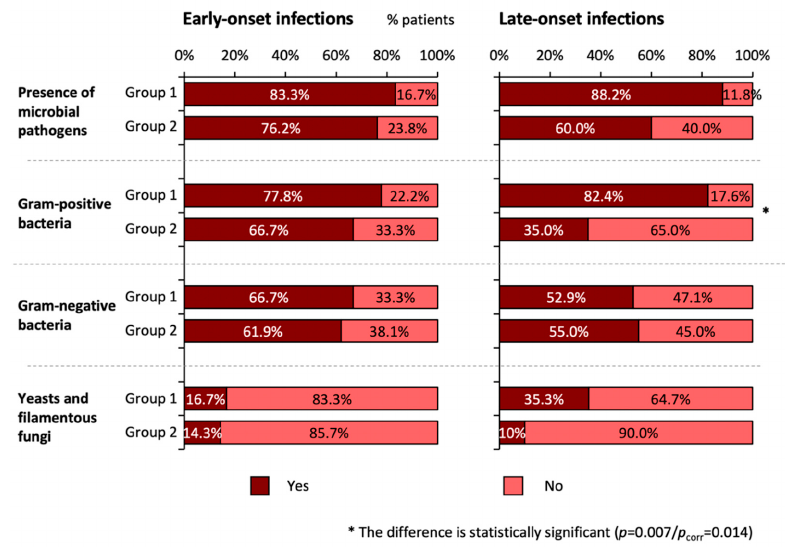
Figure 2. The incidence of early-onset ( n = 39) and late-onset infectious complications ( n = 37; 2 patients died less than 5 days after admission) in patients with toxic epidermal necrolysis (TEN) in the context of the use of antibiotics before TEN development. Fisher’s exact test was used for statistical evaluation. P corr represents values after the Bonferroni correction for multiple analyses. Corrections were made for repeated analyses in the evaluation of early and late-onset infections. group 1: patients used antibiotics immediately before TEN development; group 2: patients used no antibiotics immediately before TEN development; early-onset, infectious complications developing within less than 5 days of admission to the hospital; late-onset, infectious complications developing 5 or more days after patient’s hospitalization.